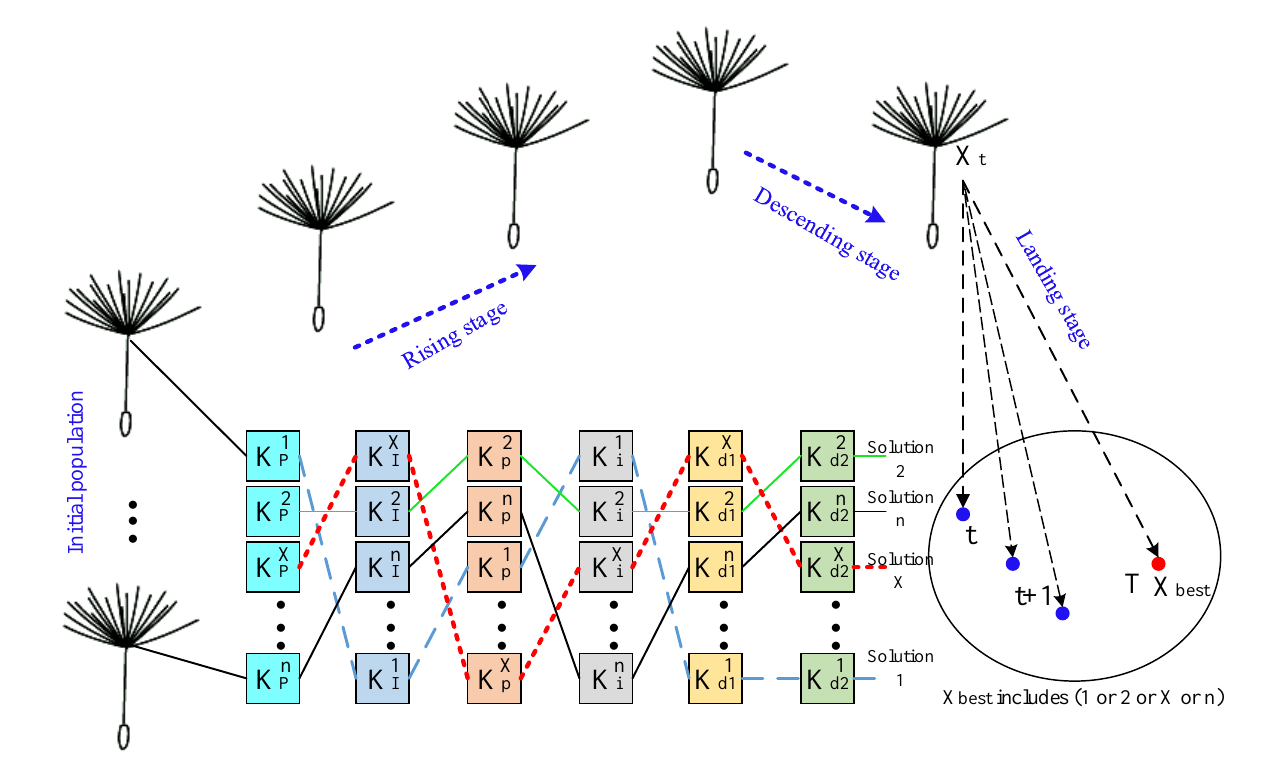
Figure 10. Generation of initial solutions with the DO algorithm.